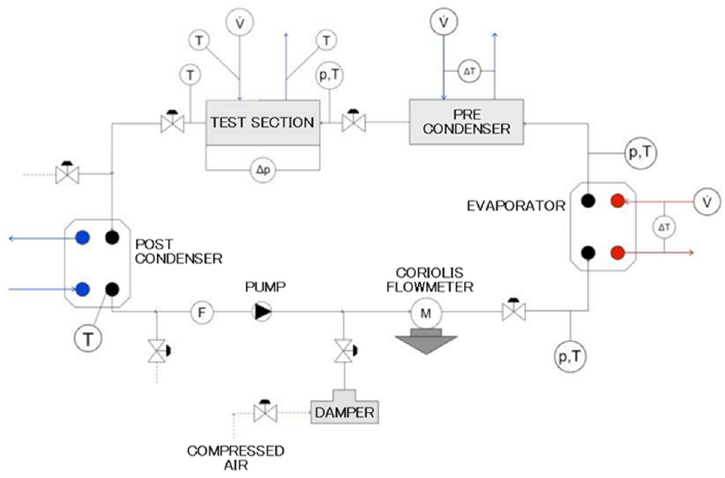
Figure 1. Schematic of the experimental test rig.